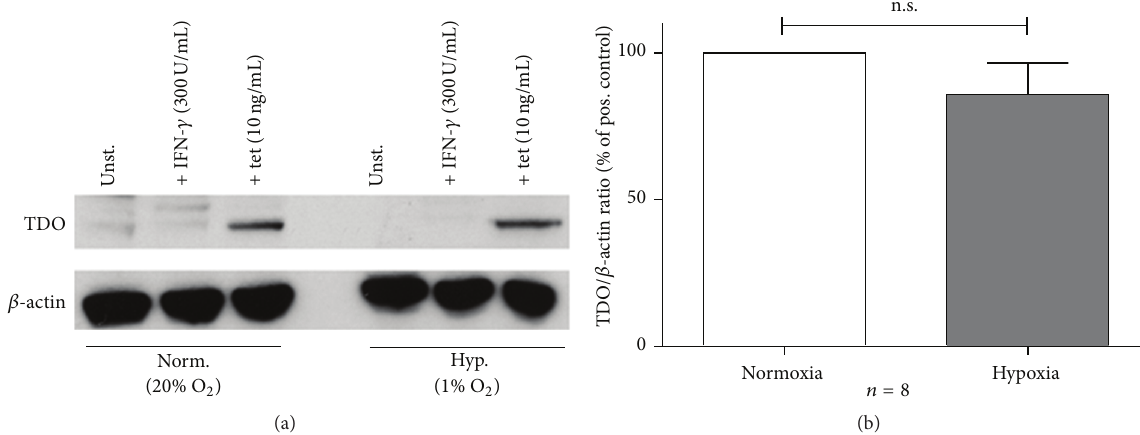
Figure 3: Unaltered hTDO expression in HeLa-hTDO cells under hypoxic conditions. (a) Exemplary Western Blot protein analysis of hTDO and 𝛽 -actin protein expression in HeLa-hTDO cells after 72 h of incubation under normoxia (20% O 2 ) or hypoxia (1% O 2 ). (b) Densitometric evaluation of Western Blot protein analyses: ratio of relative hTDO protein expression to 𝛽 -actin protein expression as % of positive control ± SEM, 𝑛 = 8 independent experiments. Comparison of hTDO/ 𝛽 -actin protein ratio under normoxia or hypoxia via a two-tailed, paired t -test; n.s. = not